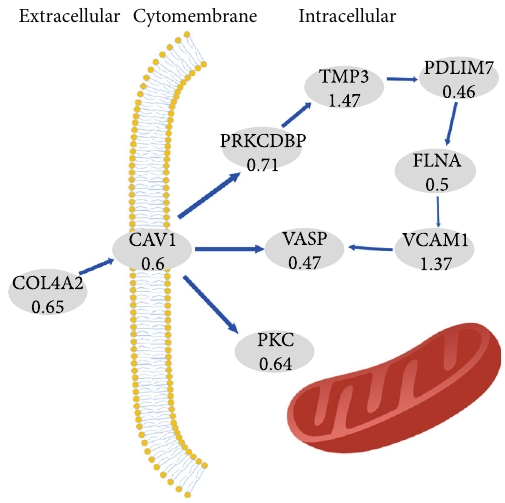
Figure 7: A simple activity fl owchart of the main di ff erentially expressed proteins.